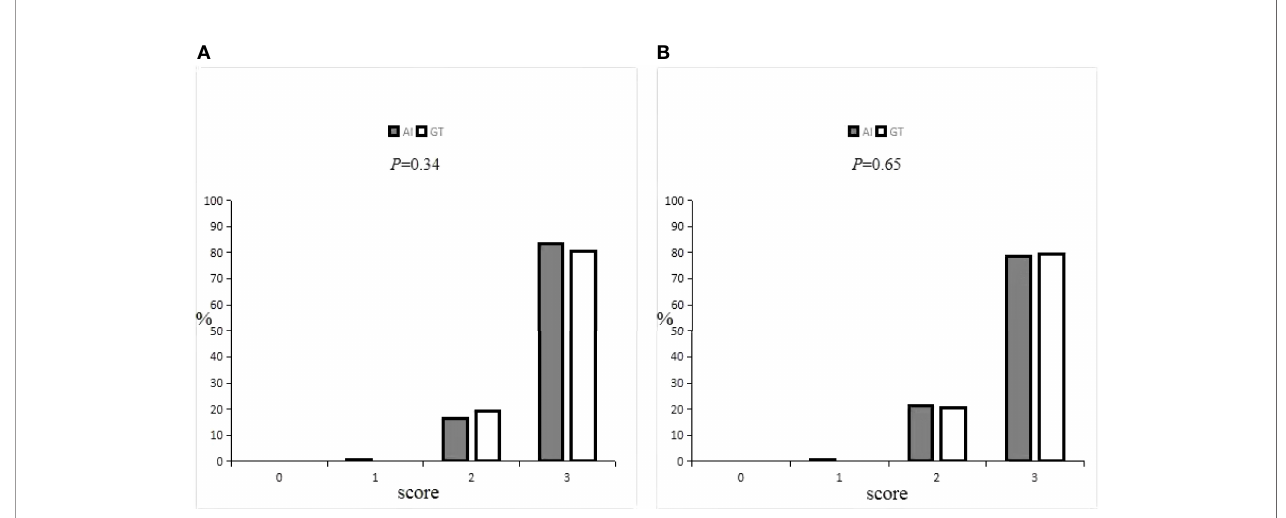
FIGURE 6 | Distribution of GTV scores by (A) and (B) oncologist.